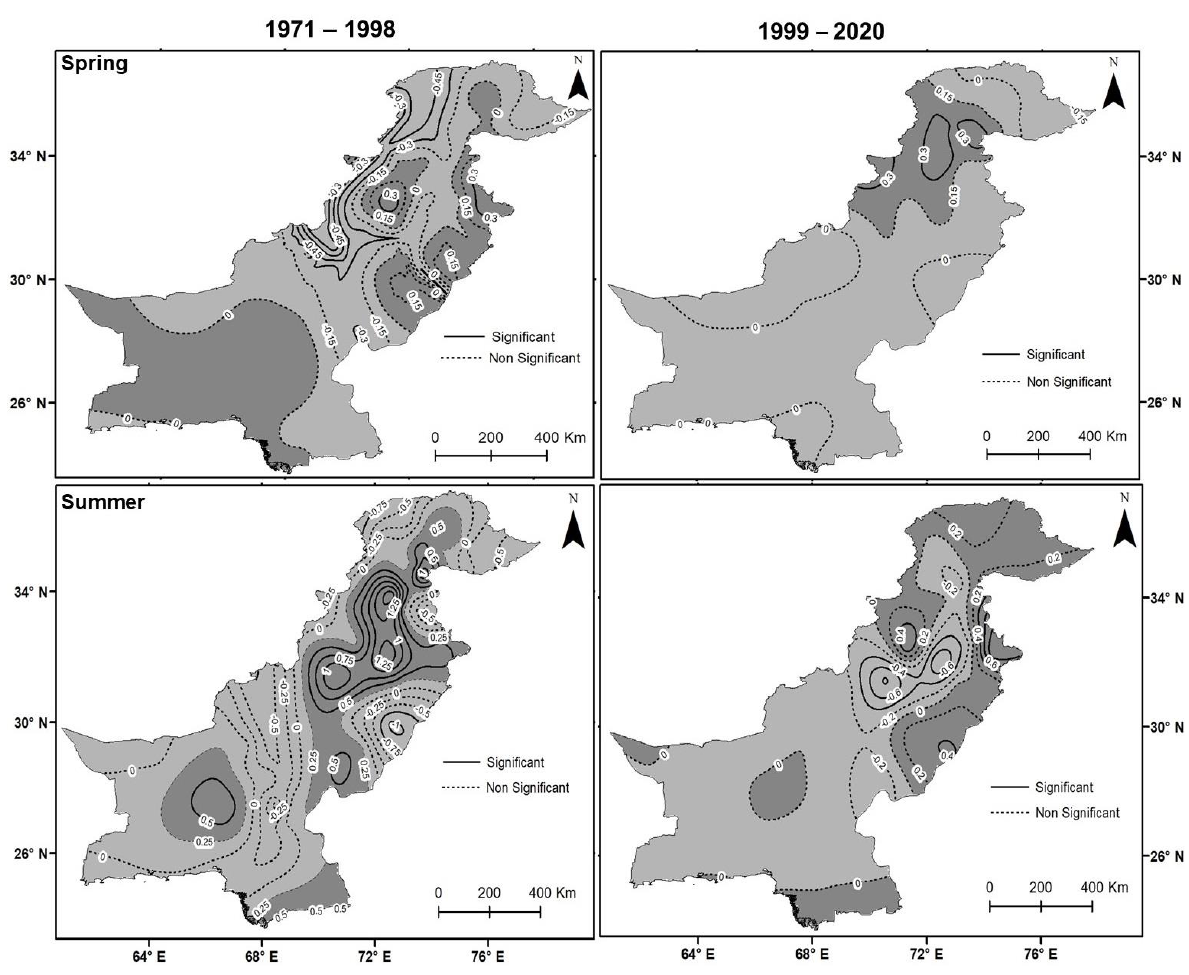
Figure 4. Spatial variation of wet days (numbers) in spring and summer season between 1971 and 1998 as well as 1999 and 2020. Dark color indicates the positive changes and light color shows the negative changes at 0.05 level of significance.